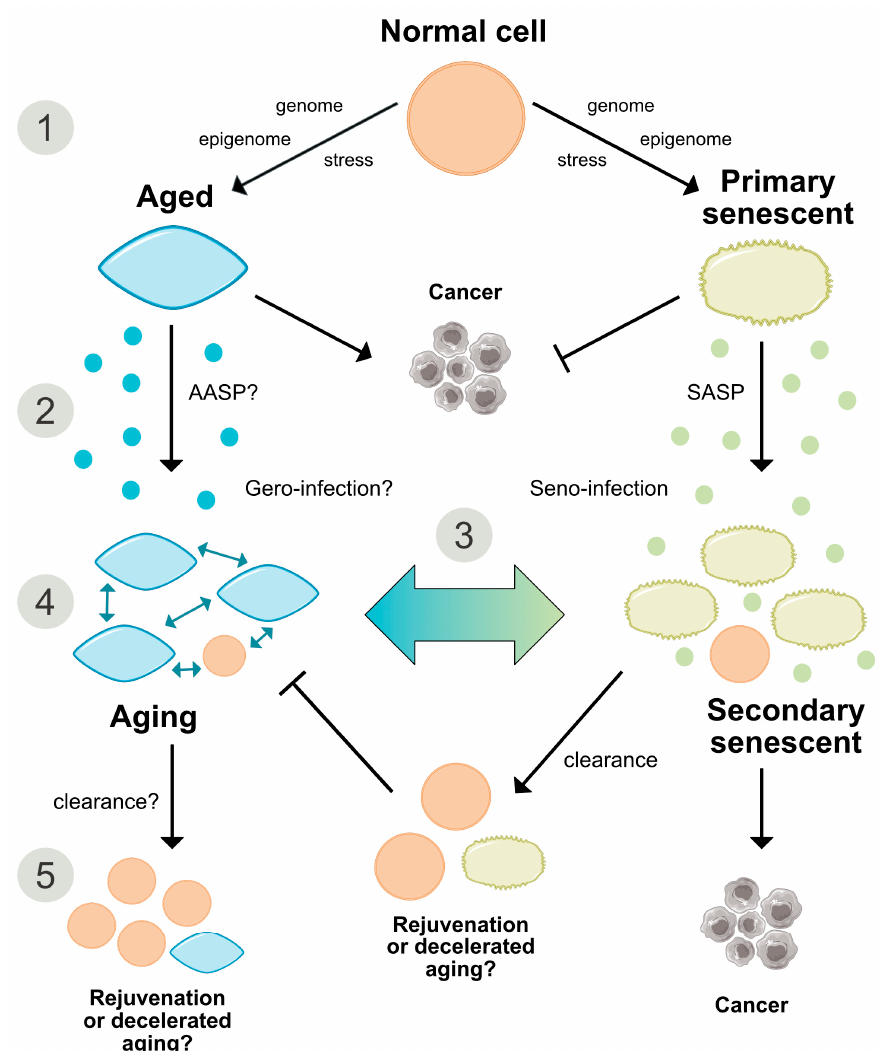
Figure 3. Comparative representation of the aging and senescence processes highlighting different levels of interaction and putative sites of interventions. ( 1 ) As discussed in the text, causative mechanisms of aging are still not well understood, however, multiple factors including genetic, epigenetic and stress-related effects seem to have an orchestrated role in the progression of aging. Senescence on the other hand, is seen as a programmed response to different kinds of stressors, which proceed in defined stages. Whether, in analogy, aging also follows a defined program or sequential stages is not known.